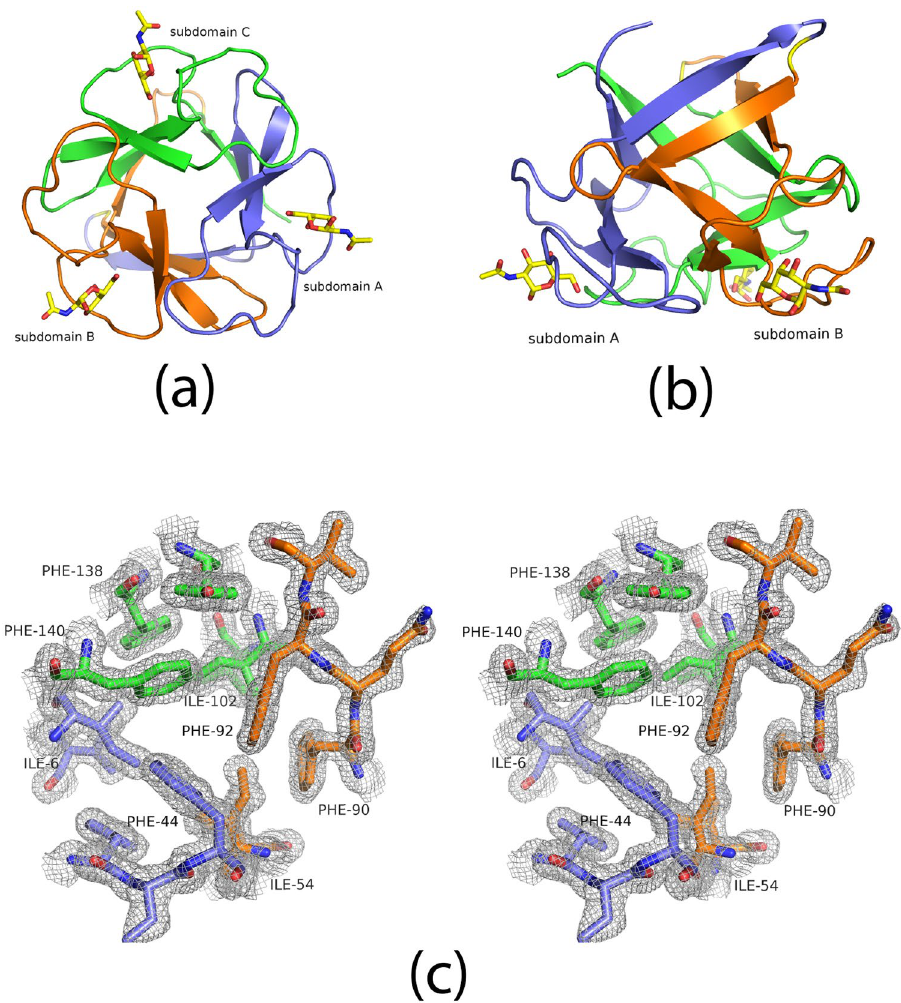
Figure 2. The overall structure of Mitsuba-1. ( a ) The C α trace of Mitsuba-1, looking along the pseudo-three- fold symmetry axis. The trace is coloured by subdomain, with α -helices shown as coils and β -strands as arrows. α -GalNAc ligands are shown as sticks with yellow carbon atoms. The subdomains are coloured purple, orange and green from N to C terminus. Structural figures were drawn using PYMOL 54 . Secondary structure was determined automatically. ( b ) A view of the model shown but with the three-fold symmetry axis vertical. ( c ) The 2mFo-DFc electron density map, shown in stereo, contoured at 1 σ , covering a selection of residues near the symmetry